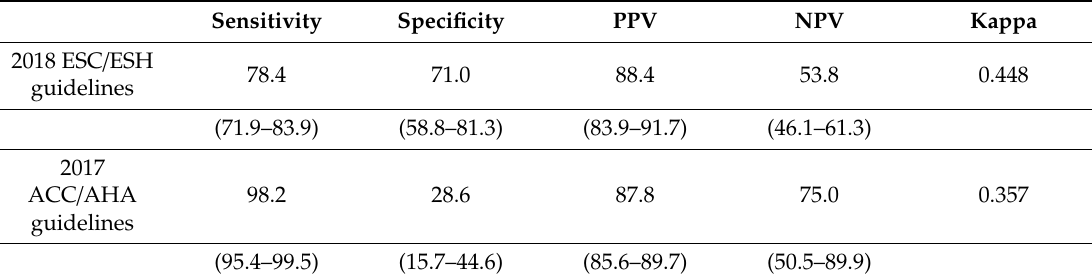
Table 2. Degree of agreement for the diagnosis of hypertension by o ffi ce measured blood pressure according to the 2018 ESC / ESH and 2017 ACC / AHA hypertension guidelines. Referenced to daytime ambulatory blood pressure.